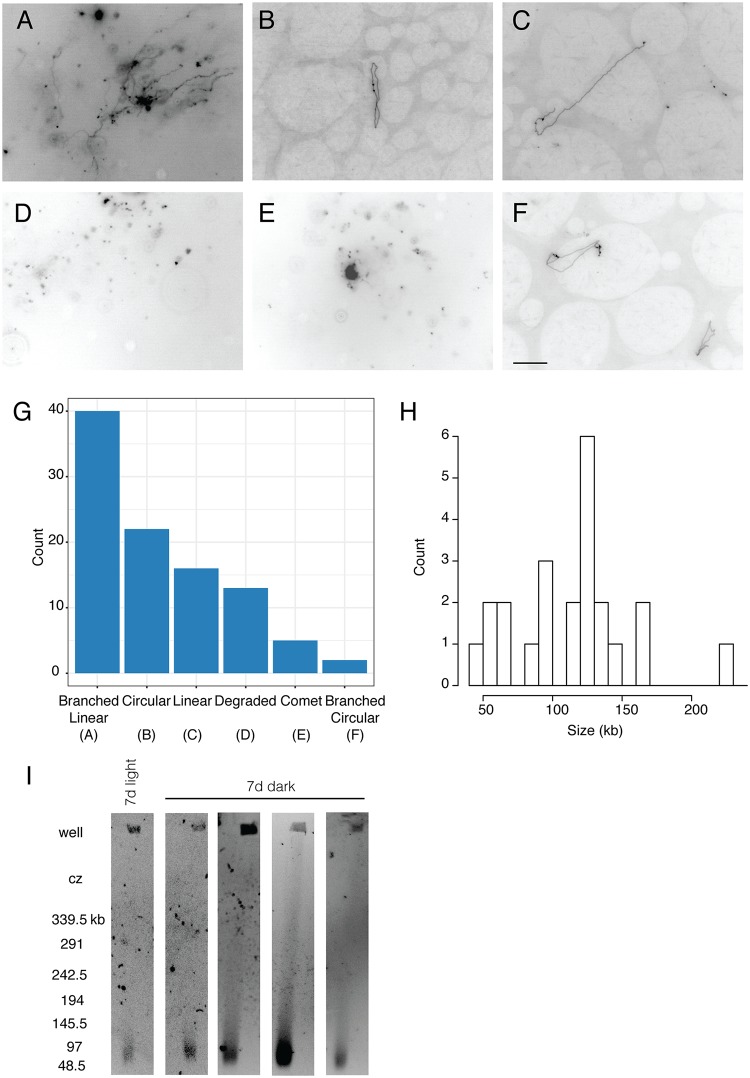
Structural analysis of L. sativa mitochondrial DNA by in-gel fluorescence microscopy and pulsed-field gel electrophoresis.(A-F) DNA obtained from mitochondria isolated from seven-day-old dark-grown seedlings (roots and shoots) was stained with either ethidium bromide or QuantiFluor dye. Images are representative of branched linear (A), circular (B), linear (C), degraded (D), comet (E), and branched circular (F) structures. The scale bar in panel F applies to panels A-F and is 10 μm, corresponding to the length of approximately 30 kb of DNA. Branched linear: interconnected linear forms with or without a densely staining central core. Circular: closed loop without any additional branches. Linear: linear fiber with no branches. Degraded: many small molecules of undetermined structure. Comet: bright core with short connected fibers and no other visible branch points. Branched Circular: closed loop structure with linear branches. G) Quantification of the primary structures observed among 98 total microscopic fields. H) Size distribution of the circular molecules based on length measurements of their circumferences. I) Pulsed-field gel electrophoresis. Each lane represents an independent gel run. Sizes (in kb) are determined from the migration of lambda concatemers run in each gel experiment. In some cases, the DNA migrated at a slight angle to the left.